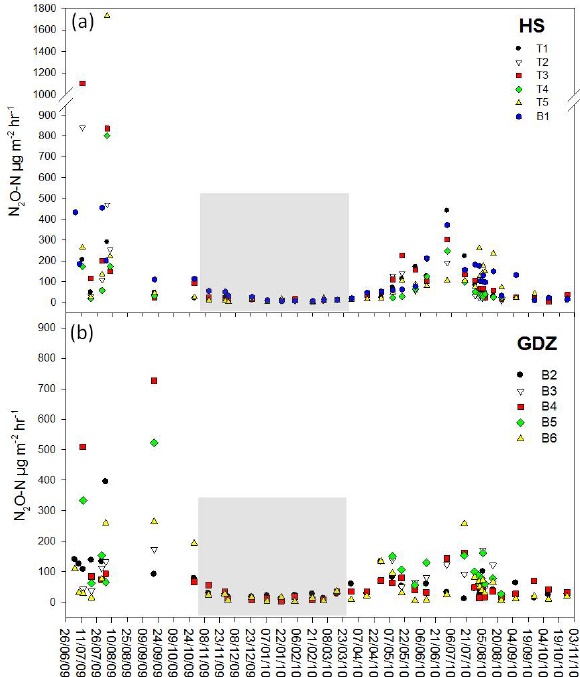
Fig. 5. (a) Mean N 2 O flux ( n = 3) at the plots on the hillslope (HS) and (b) in the groundwater discharge zone (GDZ). Standard errors are not shown to maintain readability of the figure. Shaded area indicates the dry-cool